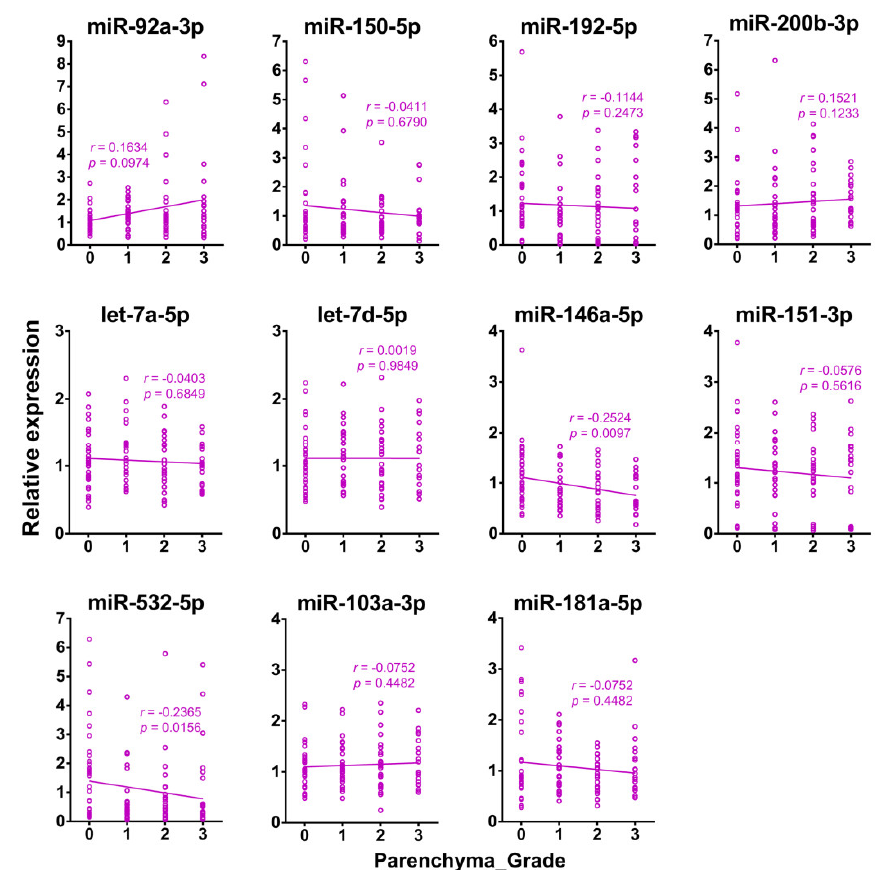
Figure 6. Correlations of the levels of eleven exomiRs in serum with hepatic fibrosis grades within the study cohort (Spearman’s r ).